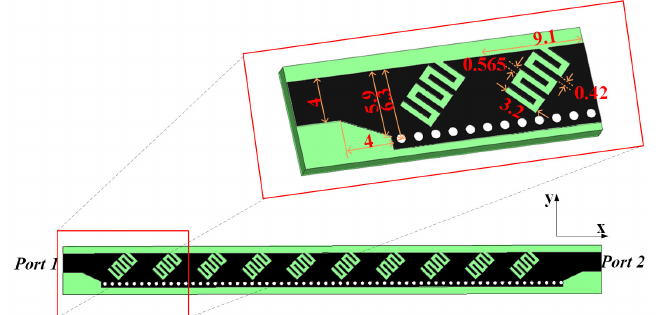
Figure 7. The optimized dimensions of the proposed interdigital slot antenna (unit: mm).